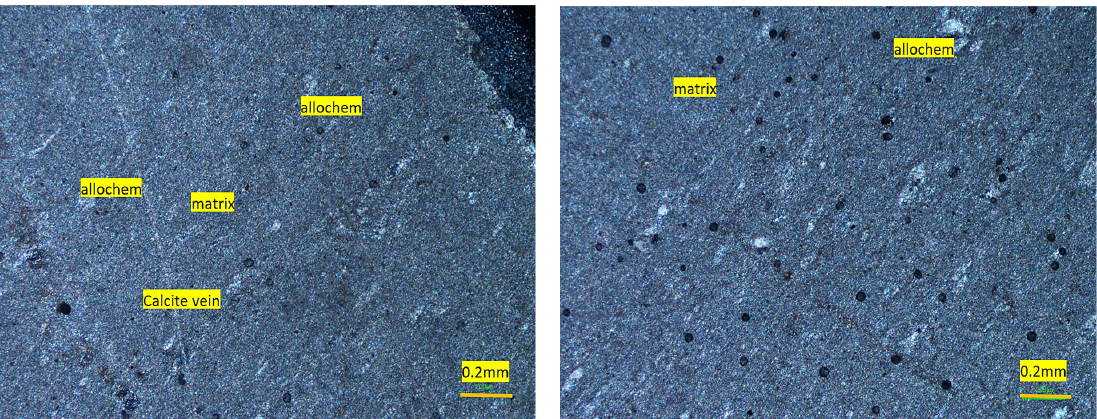
Figure 4. Photomicrographs of mudstone showing few allochems and lime mud matrix (Shalozan aggregate).